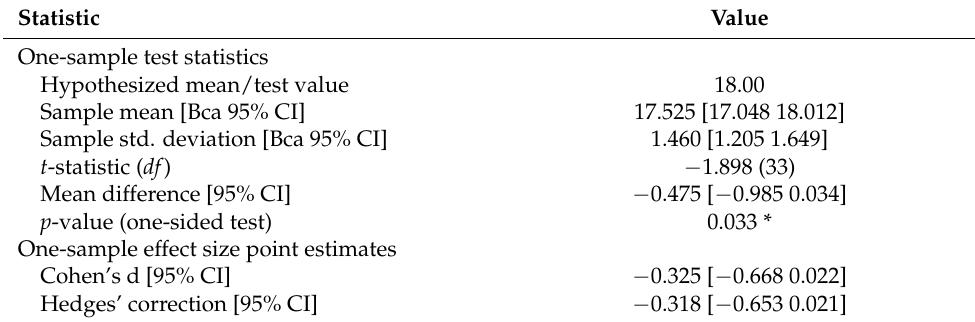
Table 5. One-sample t -test summary.